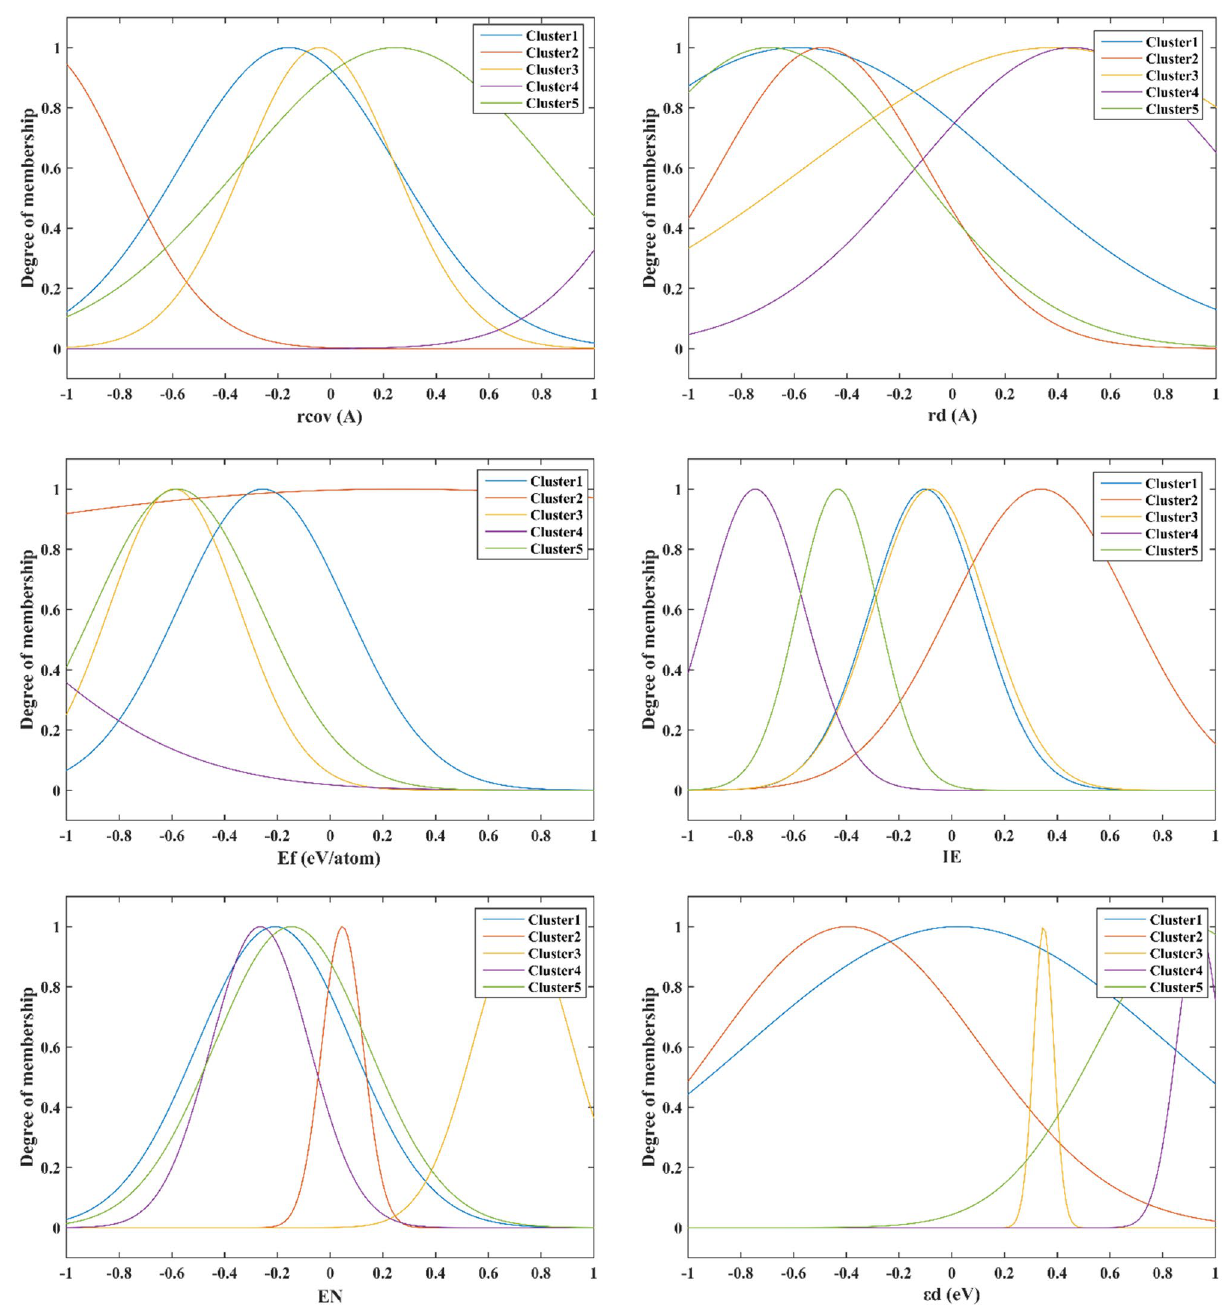
Figure 7. Optimum membership function parameters of the suggested